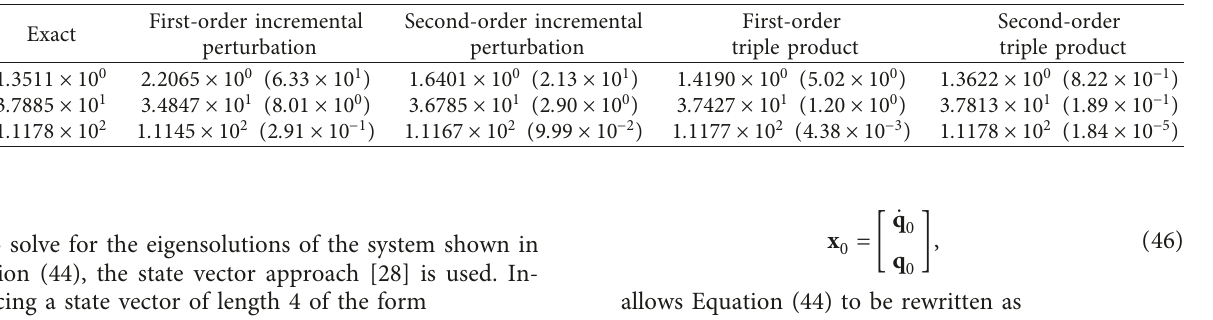
Second-order incremental perturbation